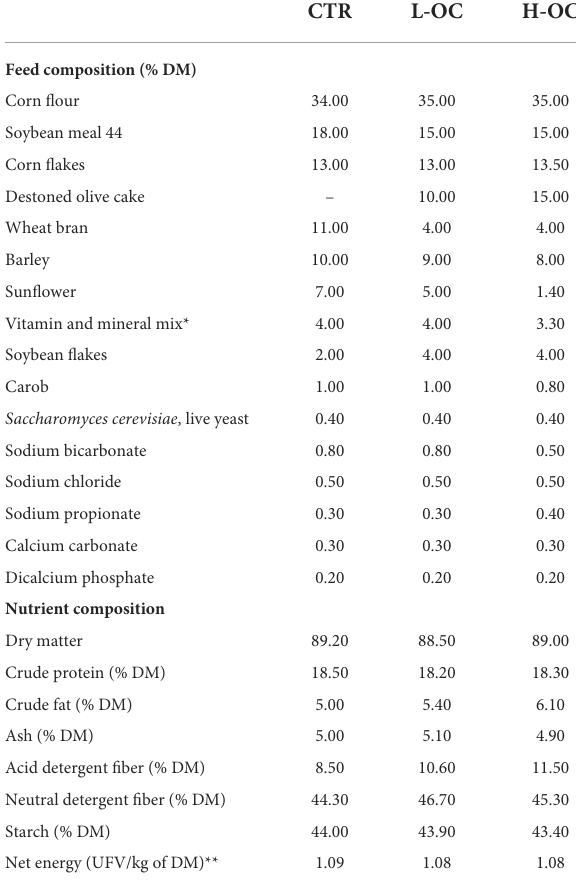
TABLE 1 Feed and nutrient composition of concentrate with 0% (Control group: CTR), 10% (Low-olive cake group: L-OC), or